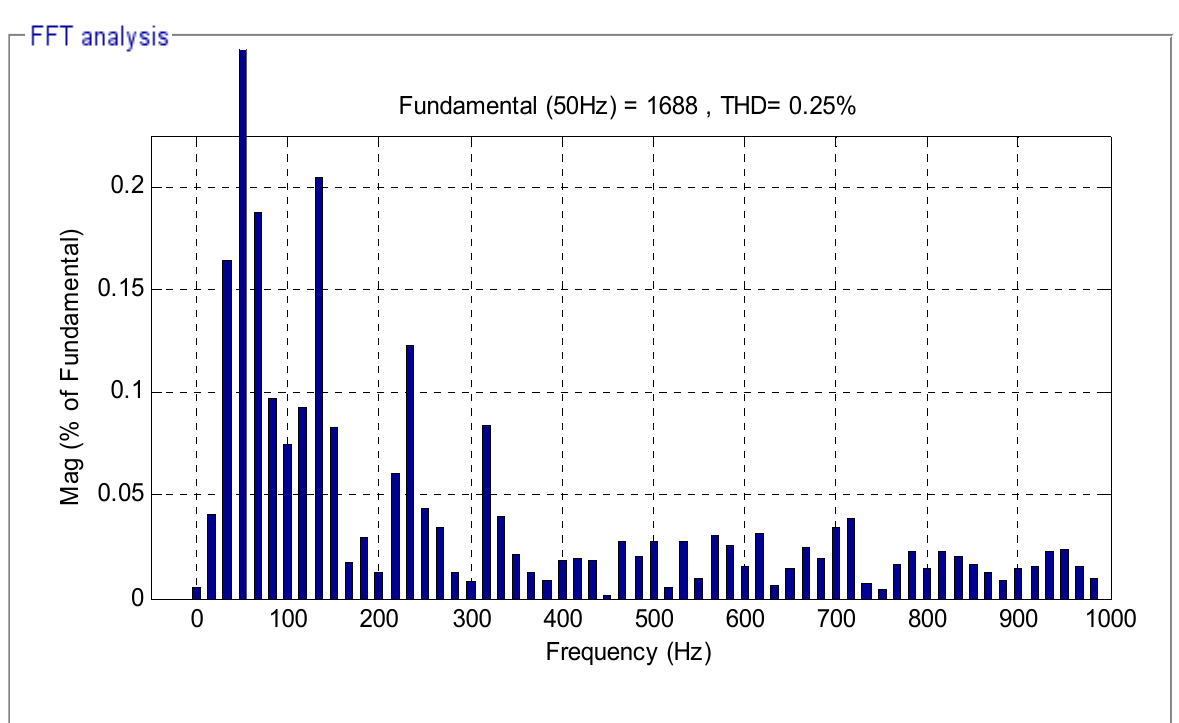
Figure 16. THD of current ( TSC-DARPC with NMSVM).